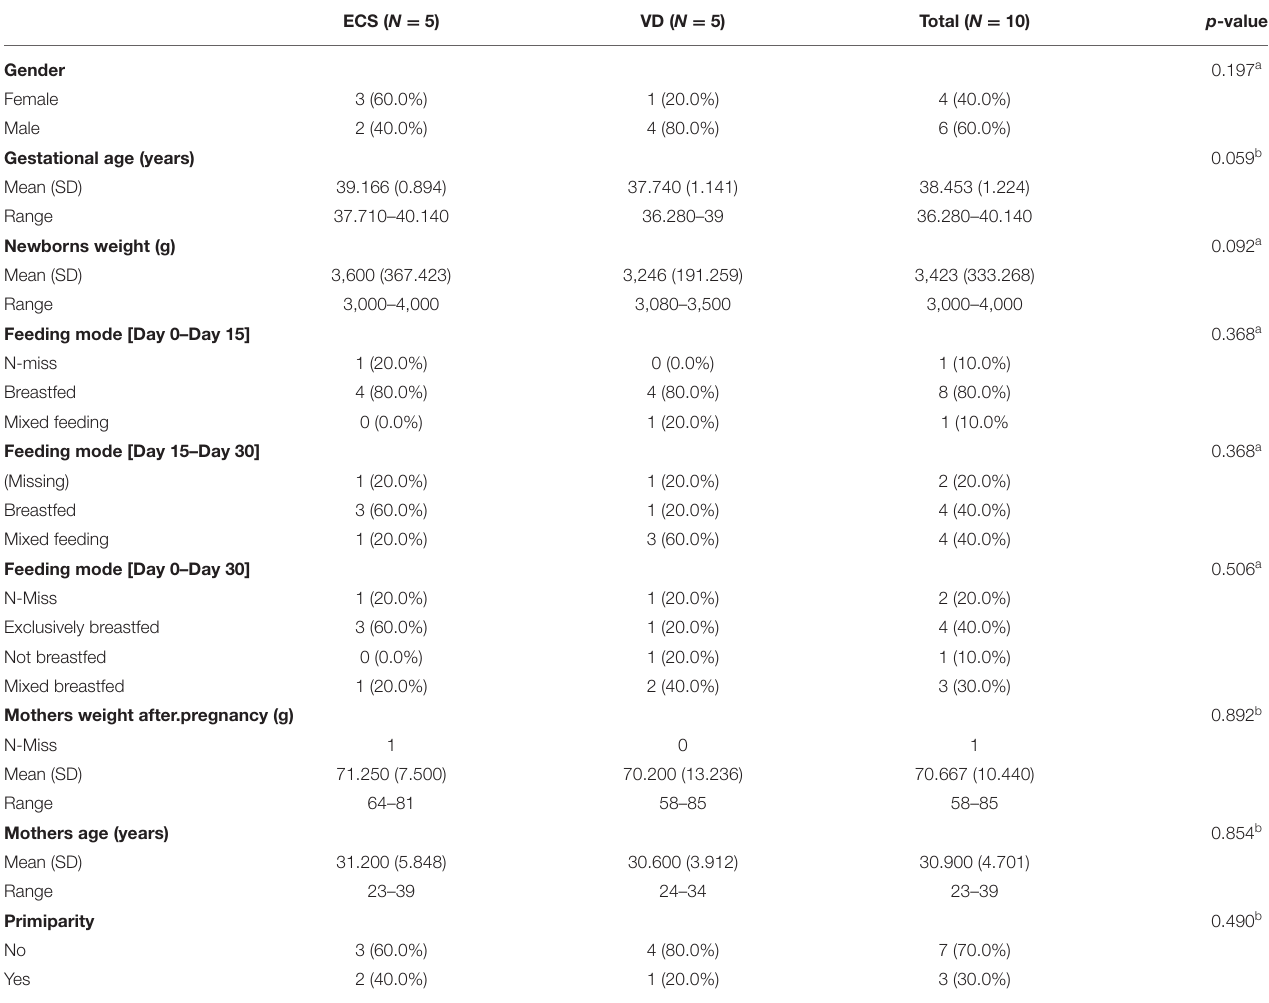
TABLE 1 | Clinical characteristics of the newborns and mothers enrolled in this